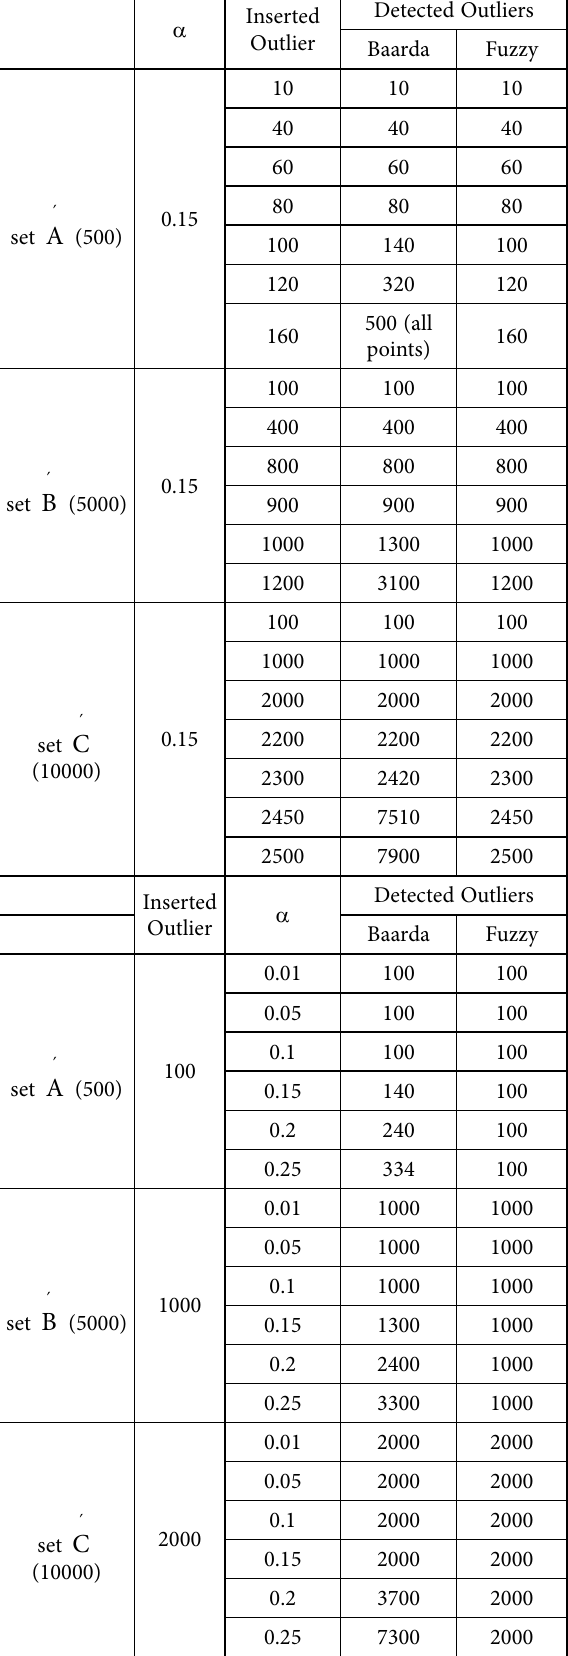
Table 5. Comparison of Baarda method and Fuzzy approach to detect inserted outliers to the randomly simulated 3D point clouds based on critical limitation value